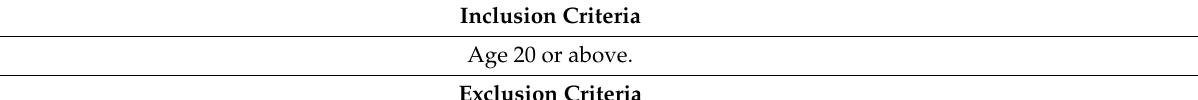
Table 1. Inclusion and exclusion criteria for participation in this